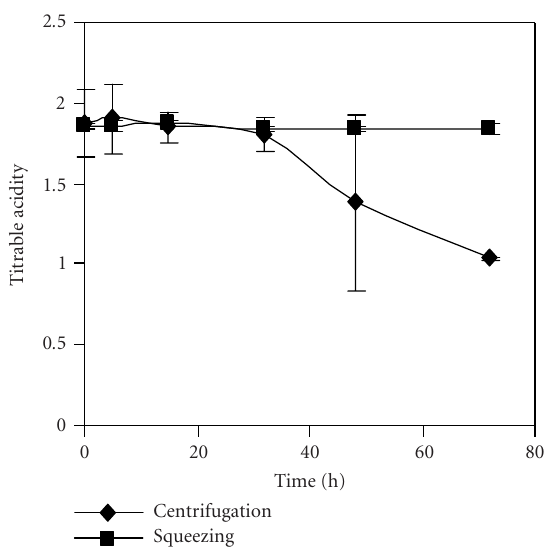
Figure 7. Evolution of titrable acidity as percentage of citric acid in the pomegranate juices obtained by centrifugation of seeds and by the squeezing of fruit halves with an electric lemon squeezer and stored for 72 hours at 4 ◦ C. Bars represent standard deviation of 4